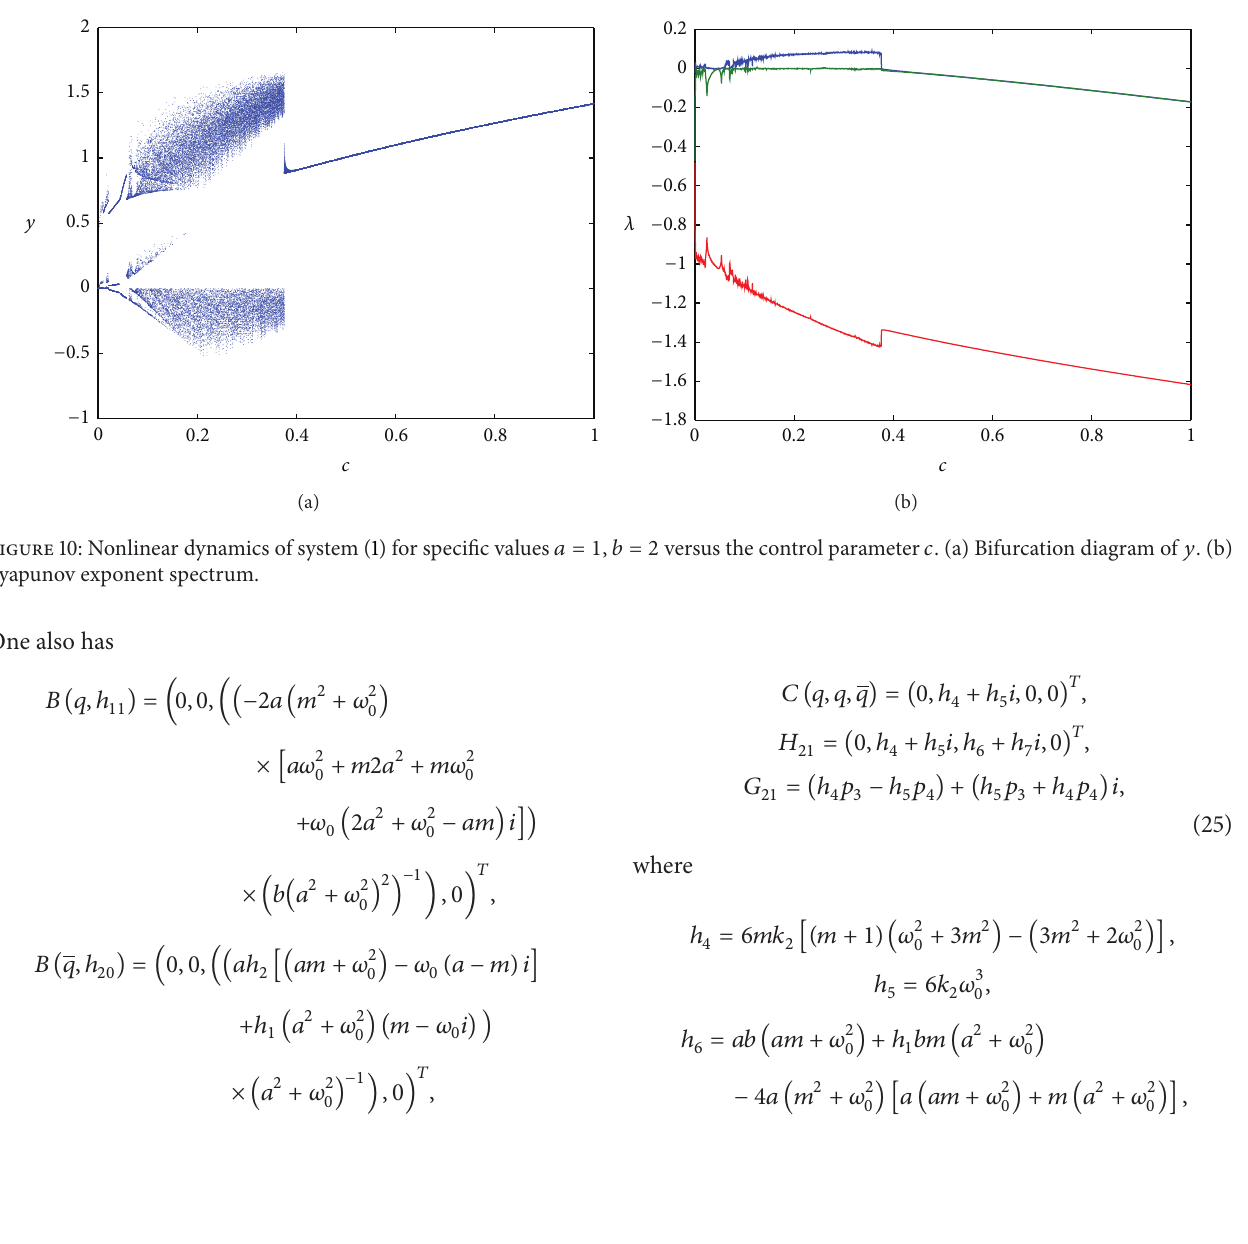
Figure 9: Time history and phase diagram of system (16) with 𝑎 = 1 , 𝑏 = 2 , and 𝑐 = 0.6998 .